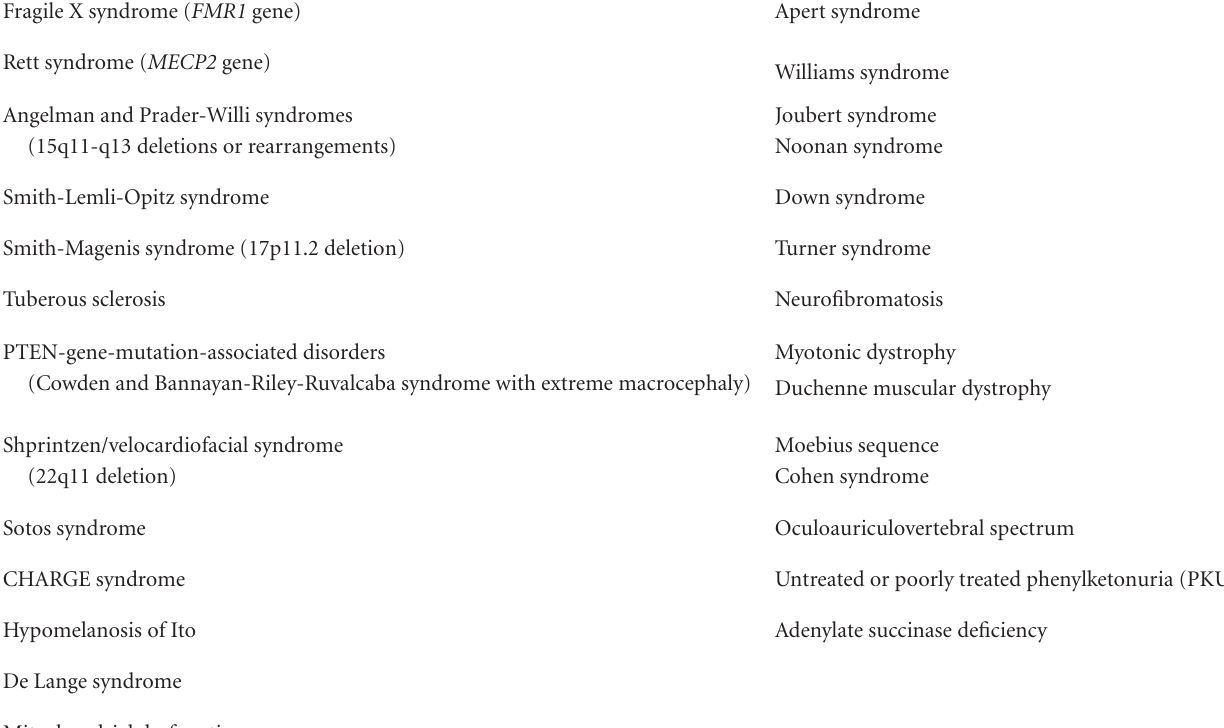
Table 1: Partial list of genetic syndromes associated with